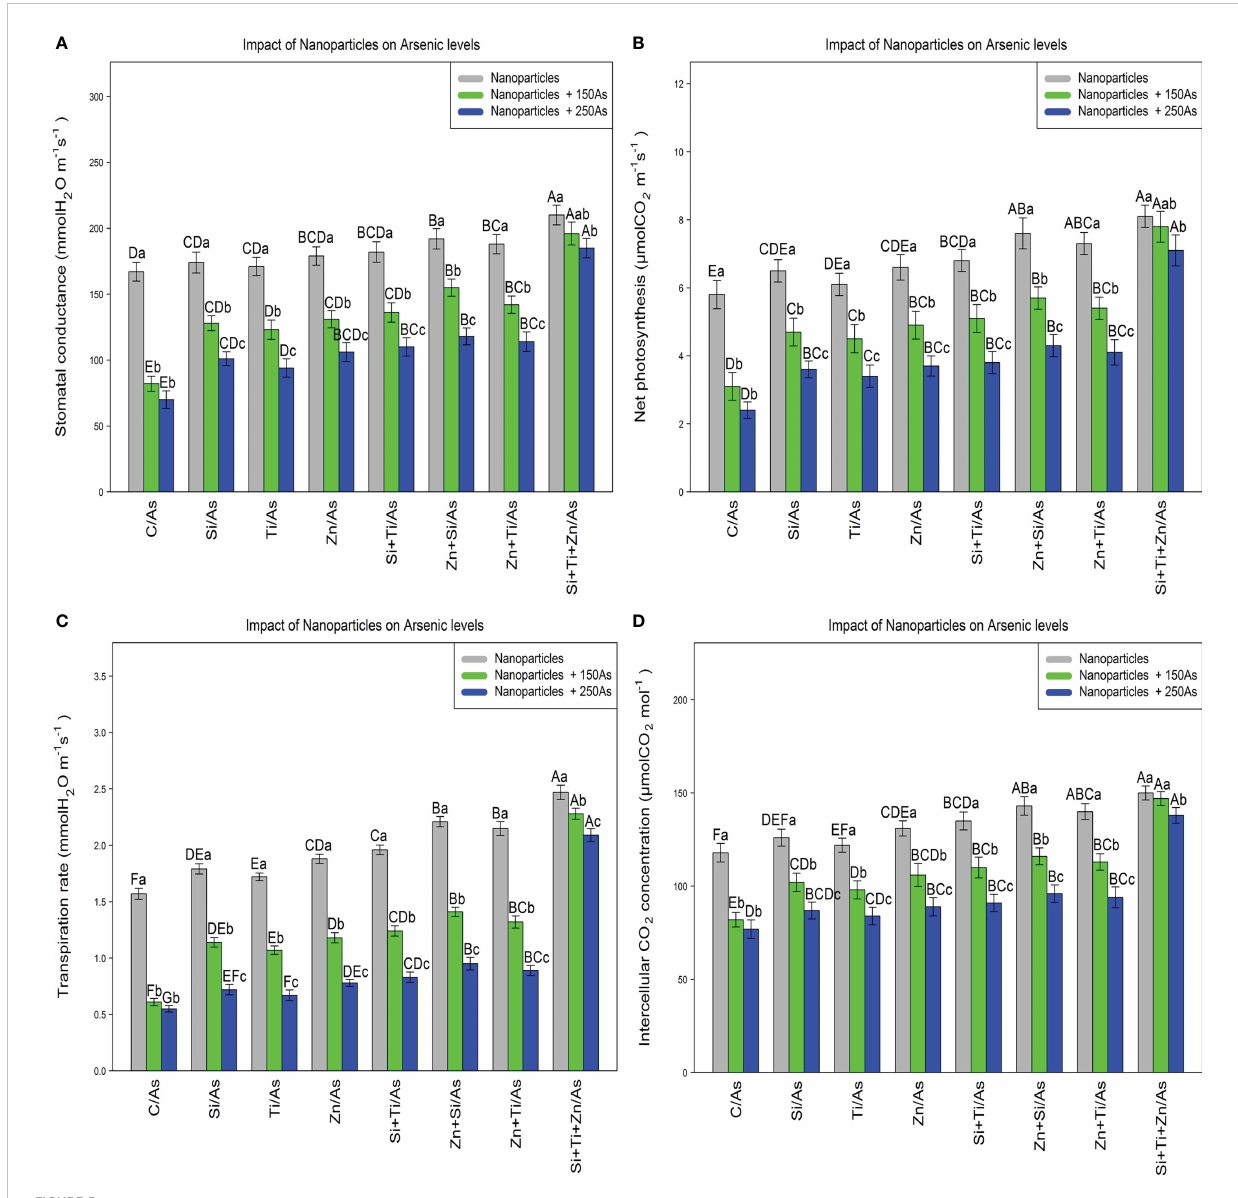
FIGURE 5 The impact of NPs alone and in combination on stomatal conductance (A) , net photosynthesis (B) , transpiration rate (C) , and concentration of intercellular CO 2 (D) in one-year-old Pleioblastus pygmaeus exposed to 150 and 250 µM As (four replicates). In this fi gure, the letters a, b, c, etc. indicated signi fi cant differences following the application of NPs with 150 and 250 µM As based on Tukey ′ s test (p<